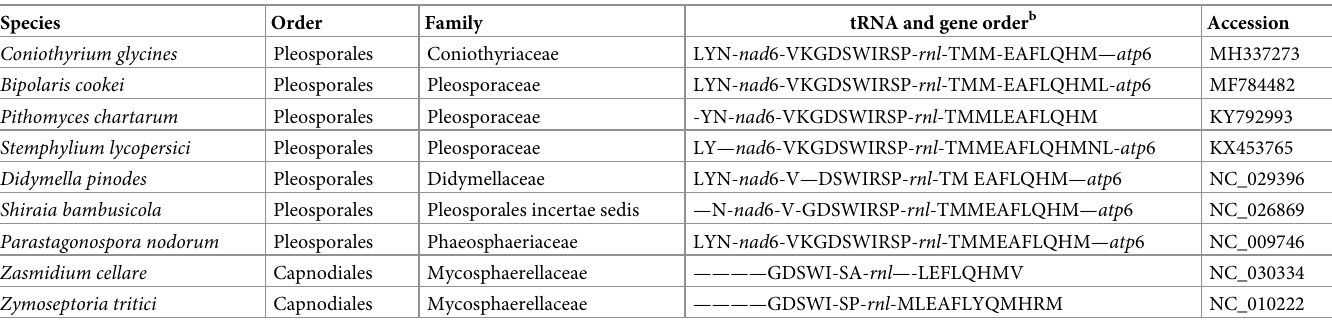
Table 3. Comparison of conserved gene and tRNA cluster patterns flanking the rnl in Coniothyrium glycines and other Dothidiomycetes a . Species Order Family tRNA and gene order b